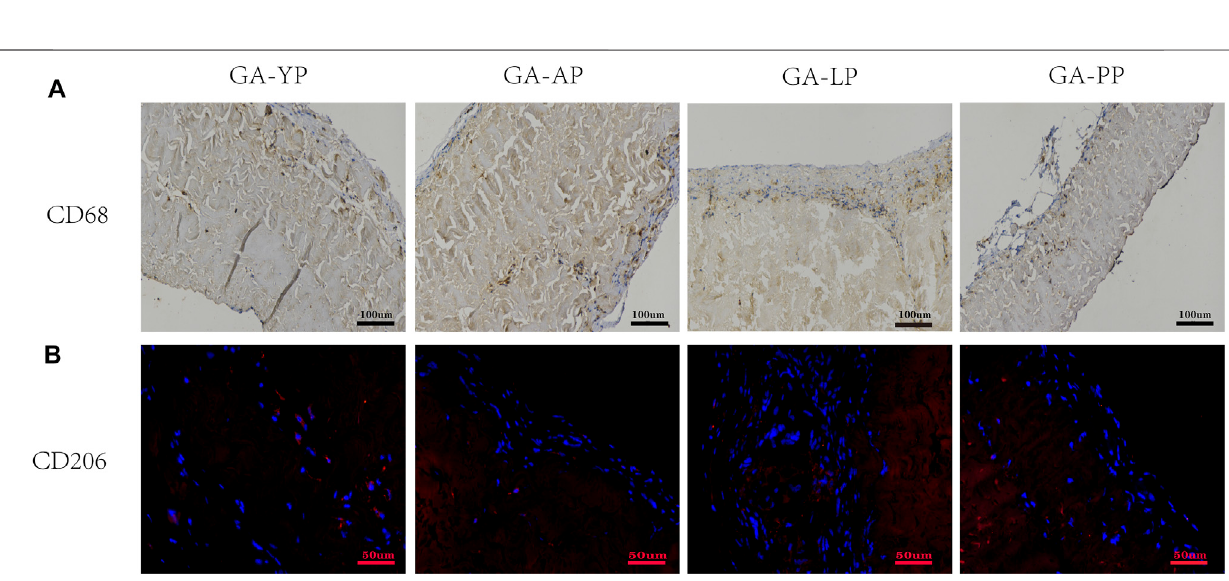
Frontiers in Bioengineering and Biotechnology |